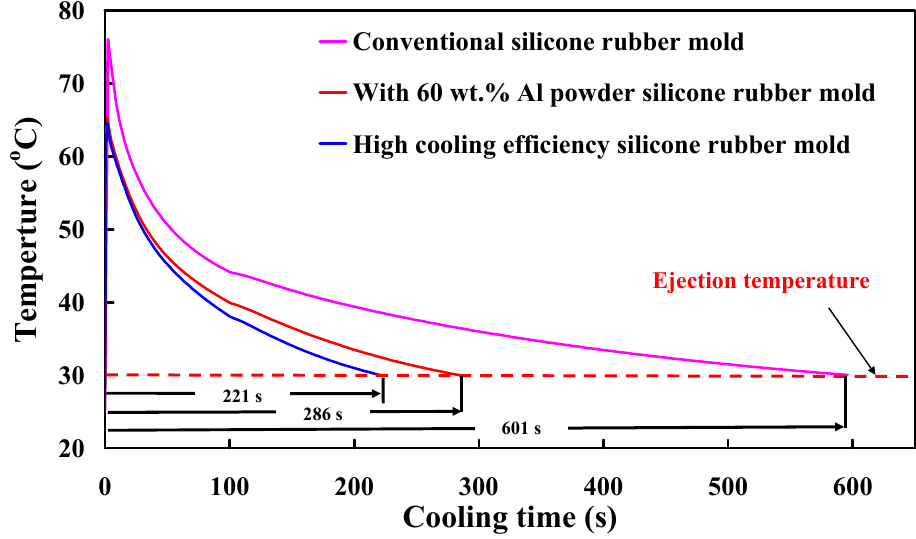
Figure 17. Numerical simulation results of the temperature of the molded wax pattern as a function of the cooling time.